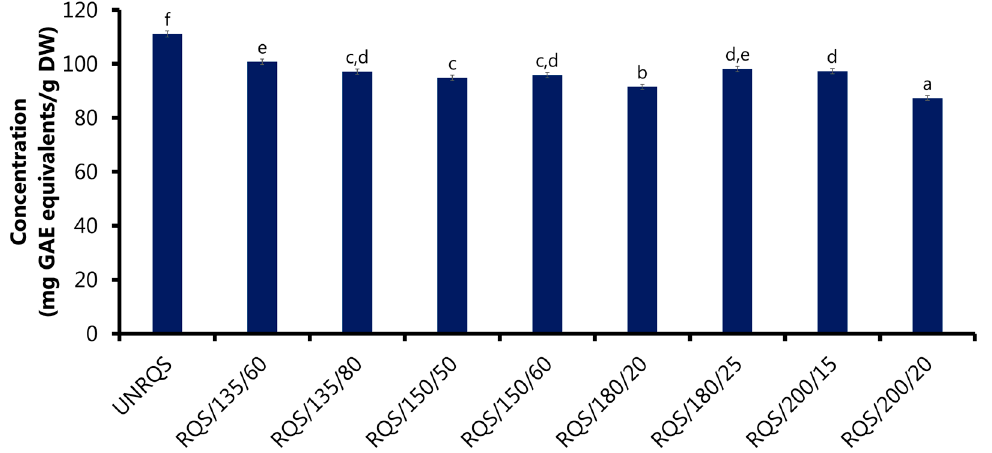
Figure 1. The total phenolics content (Folin–Ciocalteu method) of unroasted and roasted Q. rubra seeds. Results are shown as the mean ± standard deviation of three replications ( n = 3). Bars that share the same superscript letter (a–f) are not significantly different from each other (Tukey’s HSD test, p < 0.05); UNRQS, the unroasted seeds; RQS/135/60, seeds roasted at 135 ◦ C/60 min, RQS/135/80, seeds roasted at 135 ◦ C/80 min; RQS/150/50, seeds roasted at 150 ◦ C/50 min; RQS/150/60, seeds roasted at 150 ◦ C/60 min; RQS/180/20, seeds roasted at 180 ◦ C/20 min; RQS/180/25, seeds roasted at 180 ◦ C/25 min; RQS/200/15, seeds roasted at 200 ◦ C/15 min; RQS/200/20, seeds roasted at 200 ◦ C/20